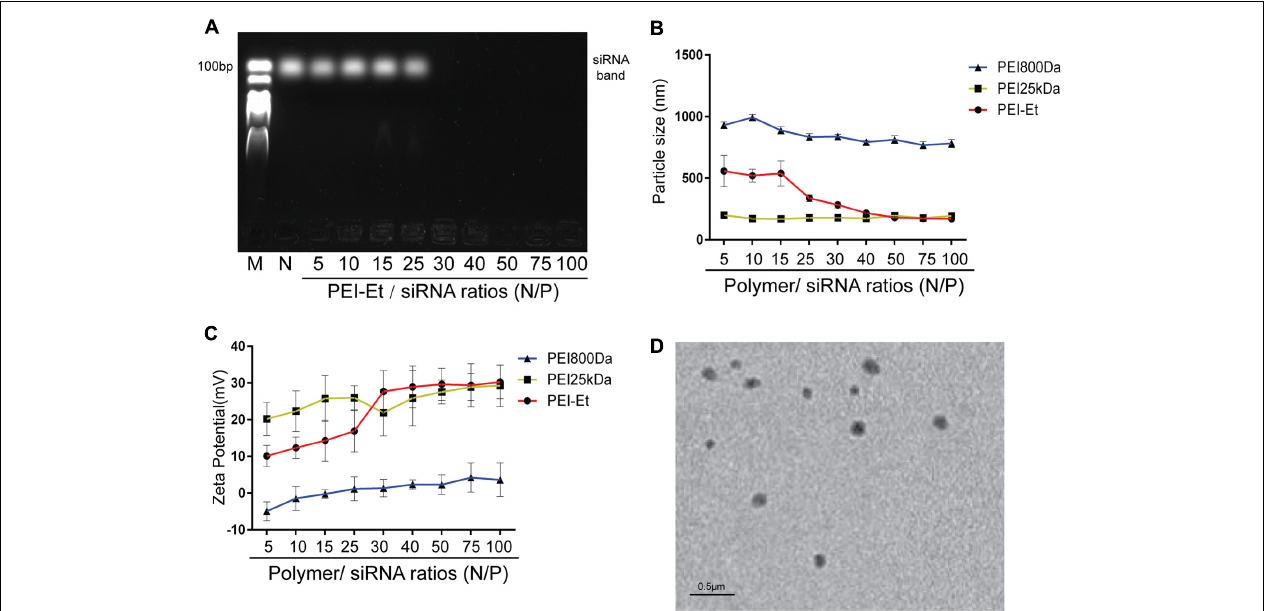
FIGURE 1 | Characterization of PEI-Et/siRNA polyplex. (A) Agarose gel electrophoresis results of the PEI-Et/siRNA polyplex. Polyplex formed from polymer to siRNA at N/P ratios of 5, 10, 15, 25, 30, 40, 50, 75, and 100. (B) Particle size of polymer/siRNA polyplex at different N/P ratios. Data are presented as mean ± SD of three independent experiments, N = 3. (C) Particle size of polymer/siRNA polyplex at different N/P ratios. Data are presented as mean ± SD of three independent experiments, N = 3. (D) Morphology of the complexes are measured with transmission electron microscope